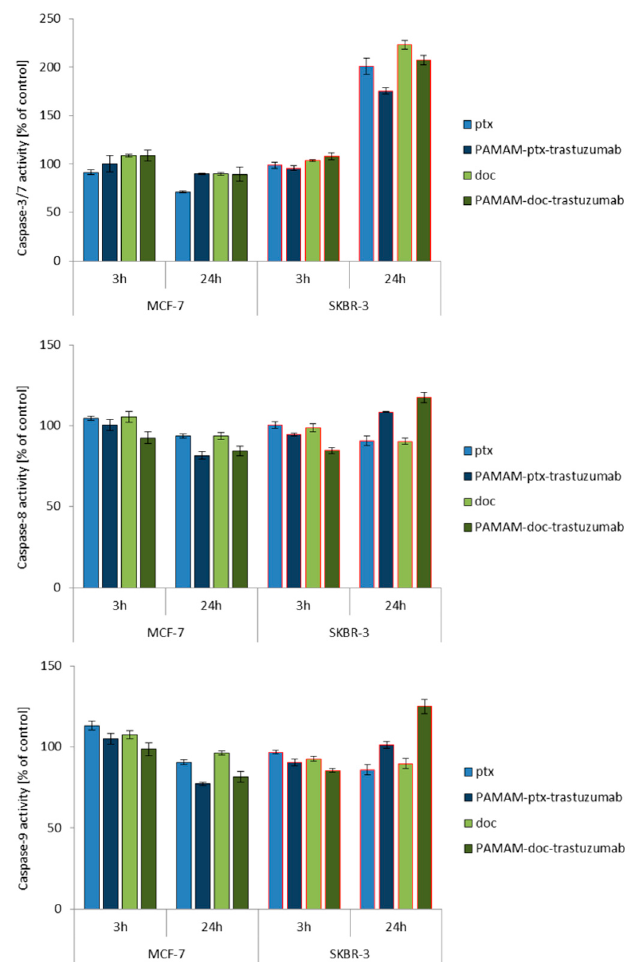
Figure 3. Influence of the PAMAM-ptx-trastuzumab conjugate, PAMAM-doc-trastuzumab conjugate, paclitaxel (ptx) and docetaxel (doc) on the caspases 3 / 7, 8 and 9 activation in MCF-7 and SKBR-3 cells after a 3 and 24 h incubation period. The results are presented as the mean ± standard deviation of three experiments.